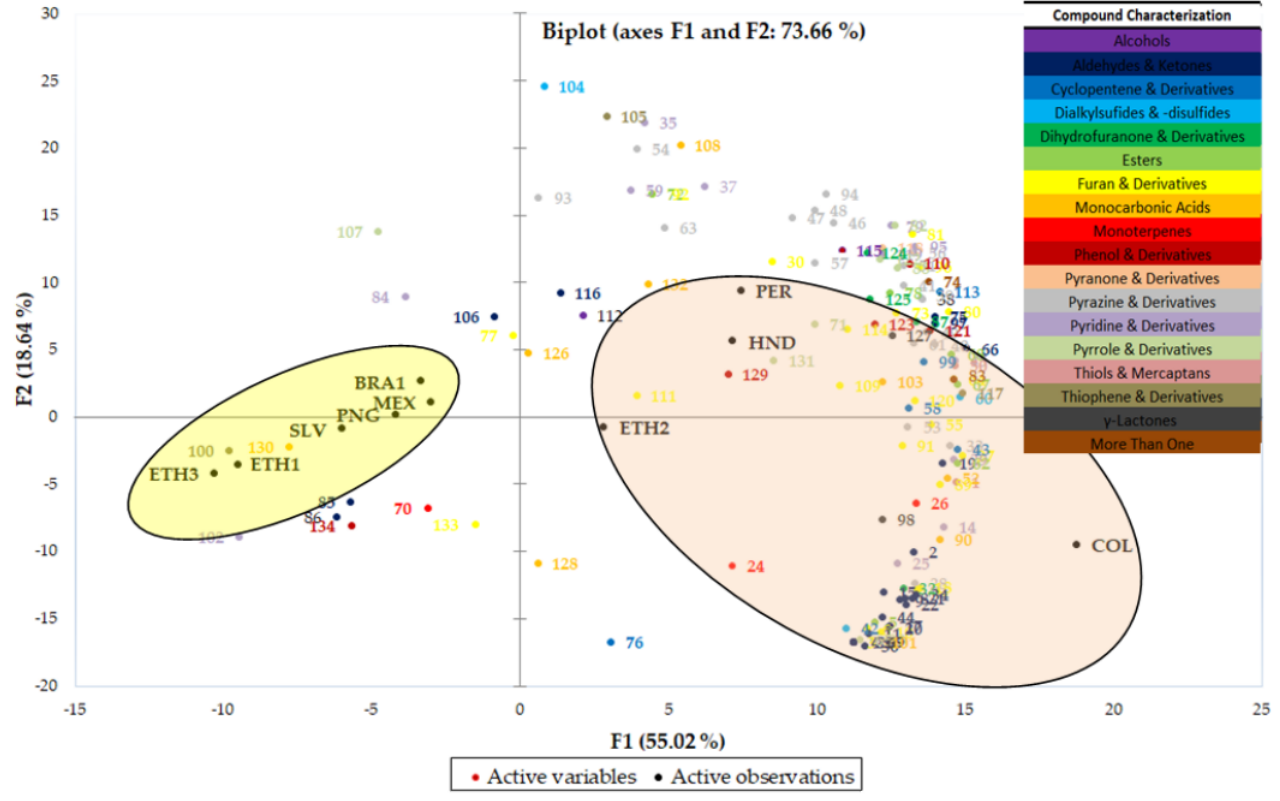
Figure 3. Principal component analysis (PCA) scores plot for coffee samples (active observations, black) based on volatile compounds (active variables,